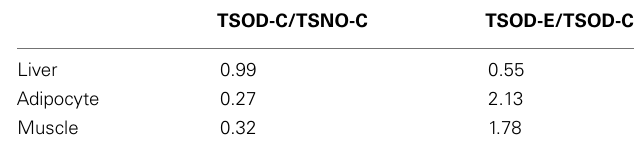
Table 2 | Fluctuation of PPAR- α